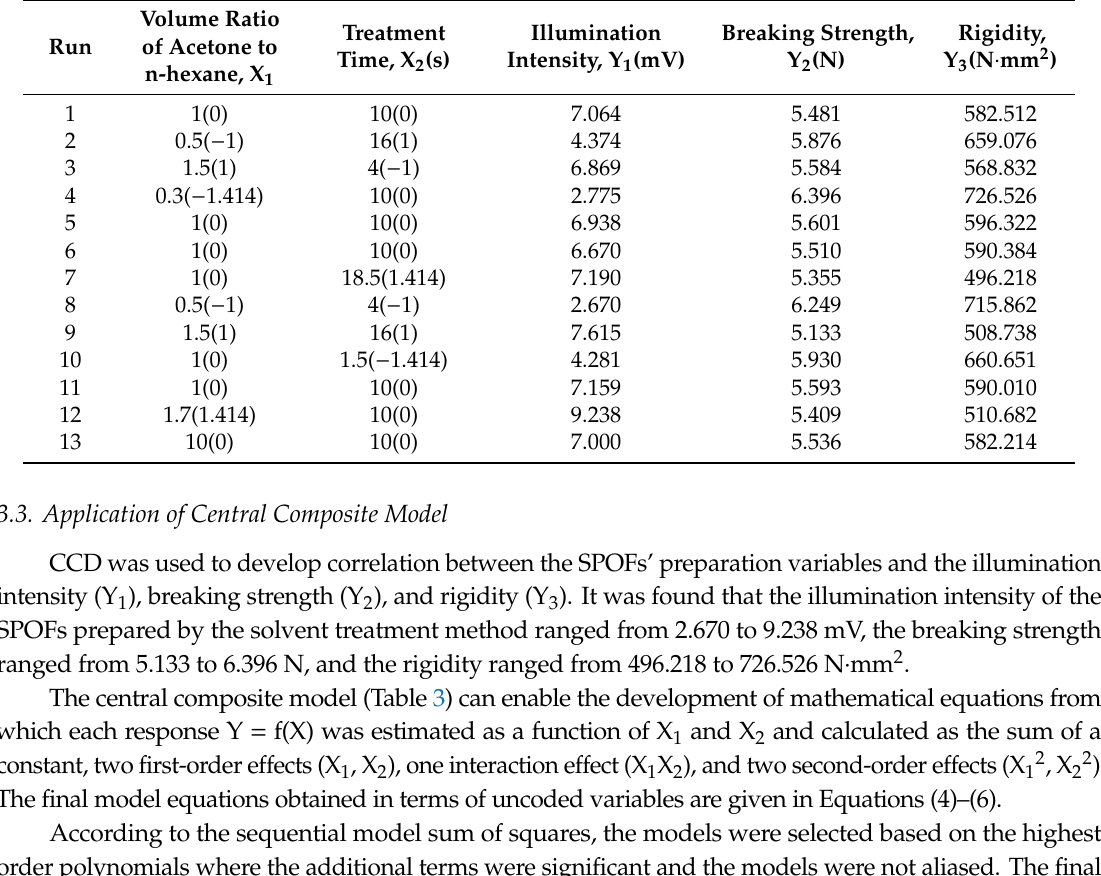
Table 3. Full factorial central composite design matrix for two test variables in uncoded units, along with the observed and predicted